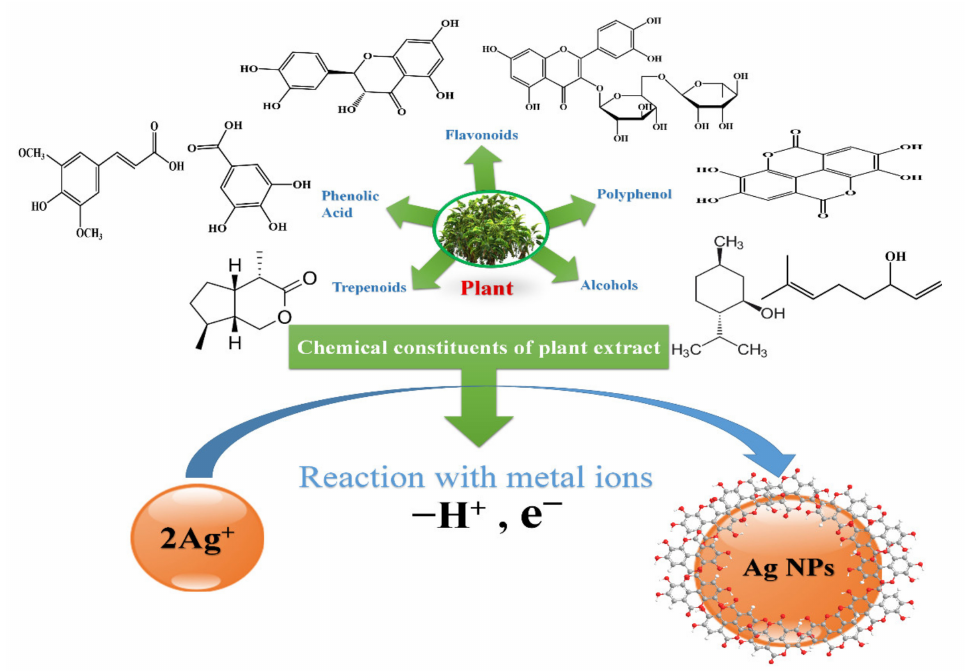
Figure 7. Ag NPs synthesis mechanism from plant extract, modified with permission from Ref. [73], Royal Society of Chemistry,